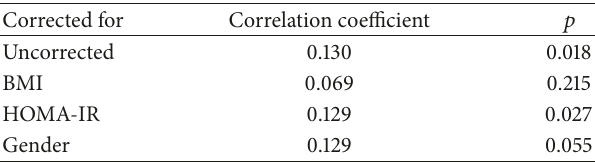
Table 8: Partial correlation between serum fetuin-A concentrations and PPAR 𝛾 Pro allele (𝑛 = 327) .